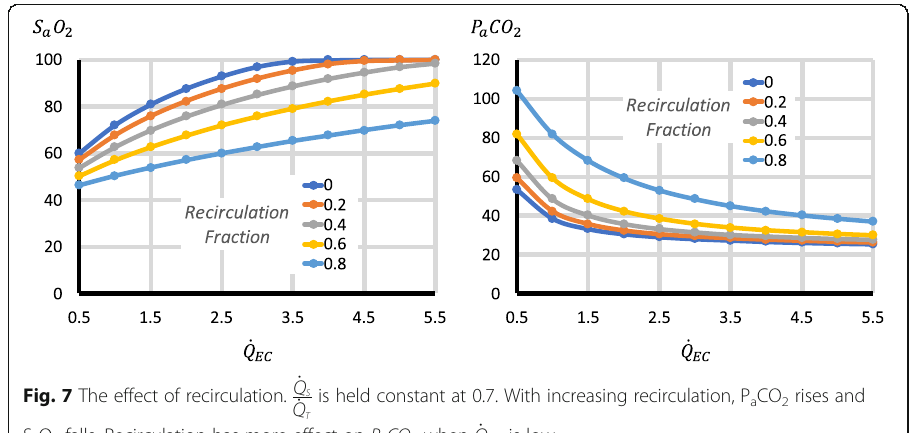
Fig. 7 The effect of recirculation. S a O 2 falls. Recirculation has more effect on P a CO 2 when _ Q EC is